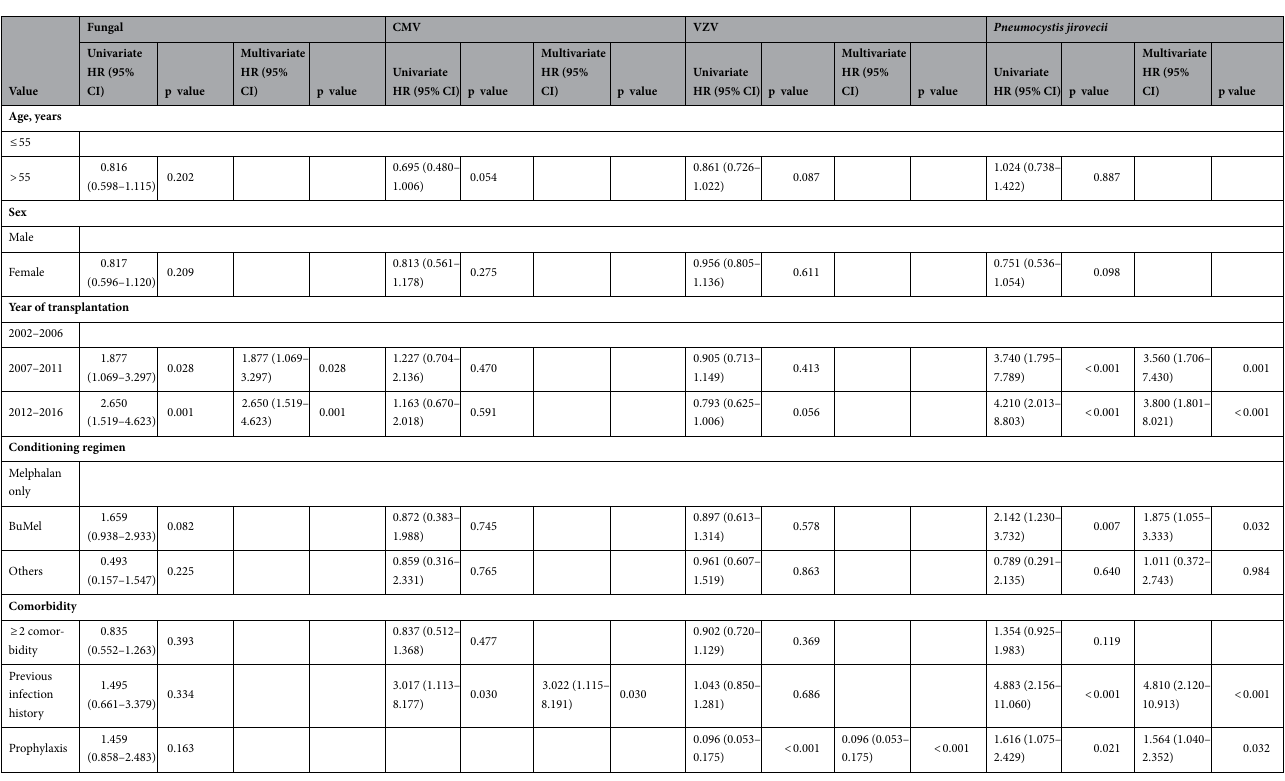
Table 3. Univariate and multivariate Cox analysis for atypical infection in multiple myeloma. CMV Cytomegalo virus, VZV Varicella zoster virus, HR hazard ratio, CI confidence interval, BuMel Busulfan and